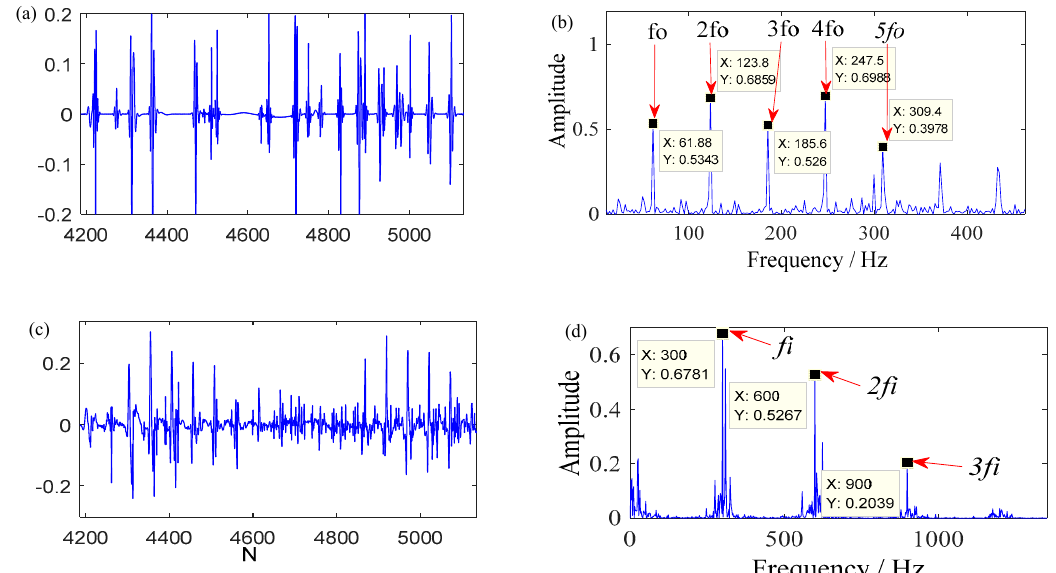
Figure 10. The analyzed results of case 1 with the proposed method: ( a ) T o = 248, low resonance component; ( b ) T o = 248, Hilbert envelope spectrum; ( c ) T i = 51, low resonance component; ( d ) T i = 51, Hilbert envelope spectrum.